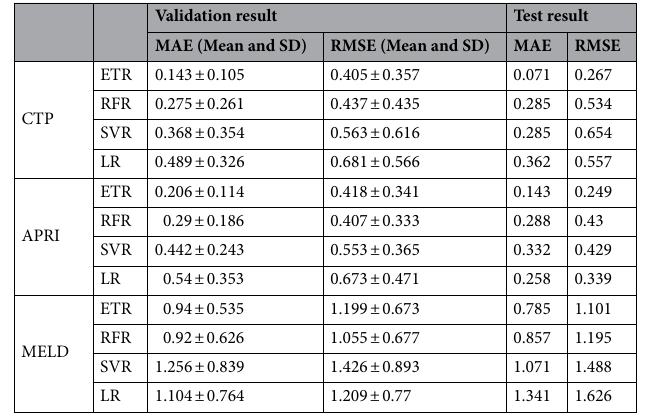
Table 3. Test and cross-validation results for the prediction of CTP, APRI, and MELD scores.